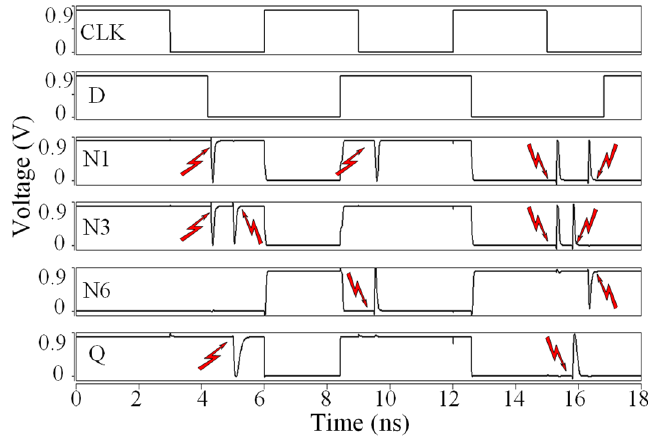
Figure 11. HLTNURL latch simulation: DNU injections.